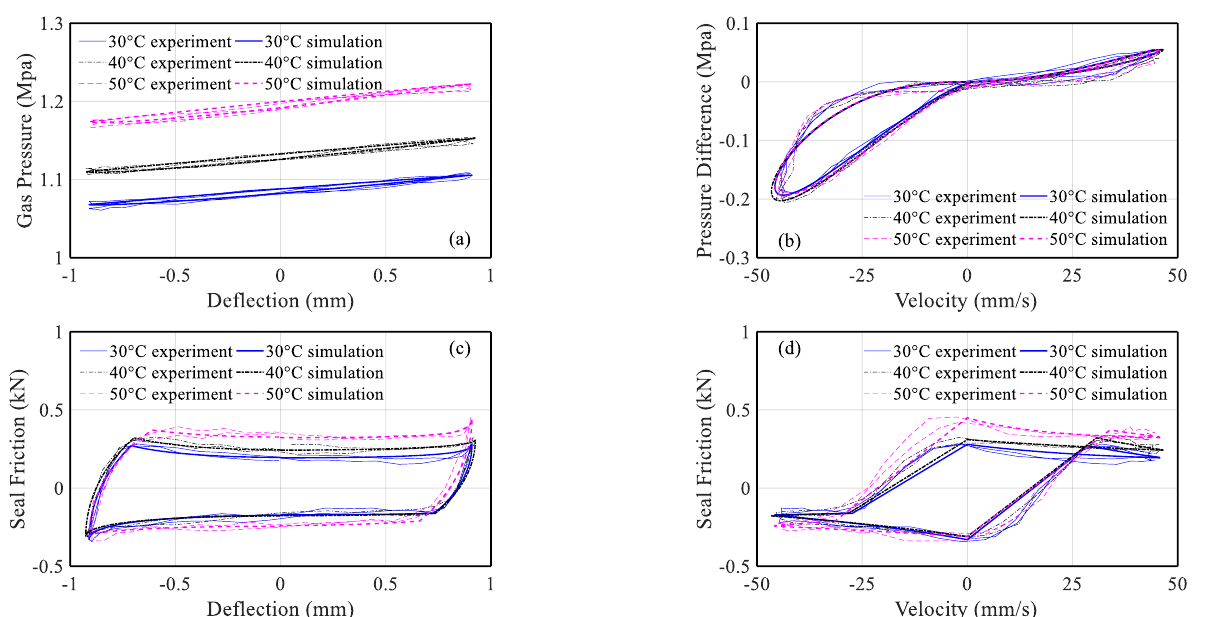
Figure 8. Comparisons of experimental and simulated gas pressure-deflection ( a ), pressure difference-velocity ( b ), seal friction-deflection ( c ), and seal friction-velocity ( d ) relationships at different temperatures (2 Hz).